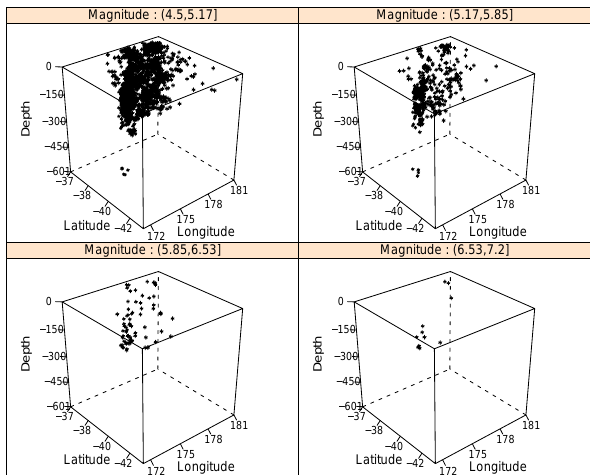
Fig. 3. 3-D scatterplot of earthquakes epicenters in terms of lati- tude, longitude and depth. Magnitude is used as the conditioning variable.